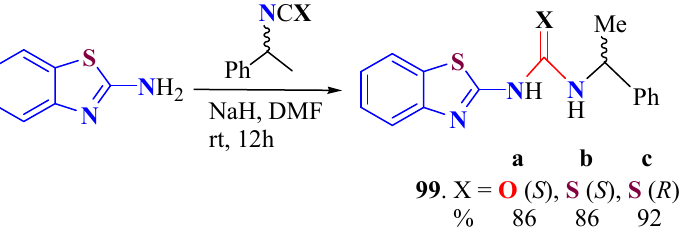
Figure 13. General structure of tested Frentizole derivatives. Chiral UBT 99a and chiral (T)UBTs 99b , c were synthesized from the reaction of 2ABT with sodium hydride NaH in DMF, followed by addition of the respective chiral-(1-isocy- anatoethyl)benzene, and stirred for 12 h at room temperature, Scheme 40 [173]. All com- pounds were in vitro evaluated for their antimicrobial activity against B . cereus, S . aureus, E . coli , and P . aeruginosa . The results indicated all compounds were only active in Gram- positive bacteria. The UBT 99a and TBTs 99b and 99c with either R - or S -configurations or